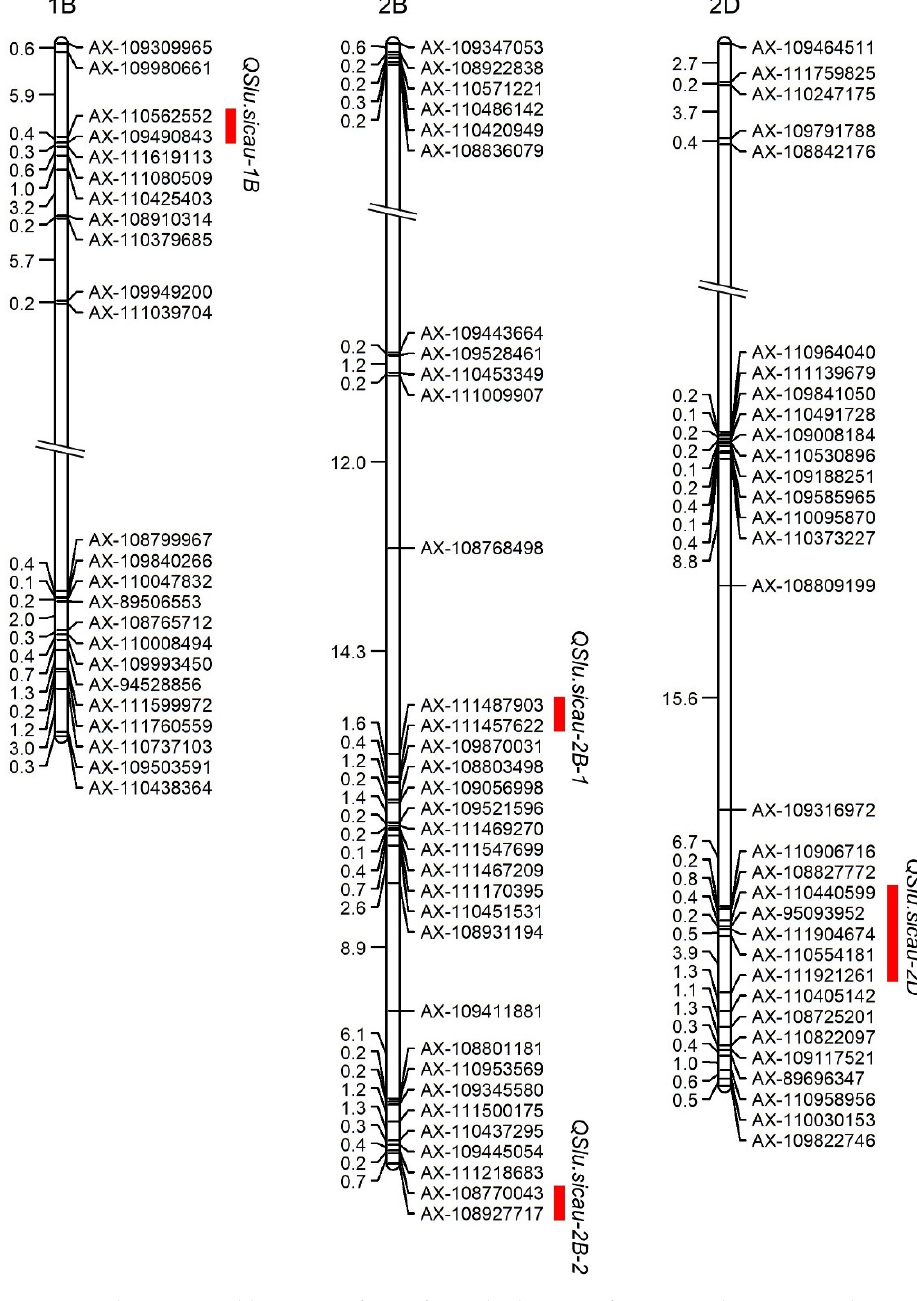
Figure 2. Chromosomal locations of QTL for spike-layer uniformity in the H461 × Chinese Spring recombinant inbred line population. The red bar points to the genetic interval of QTL. The numbers on the left side of the chromosomes point to the genetic distance (cM) between the markers. The marker’s names are shown on the right side of chromosomes.